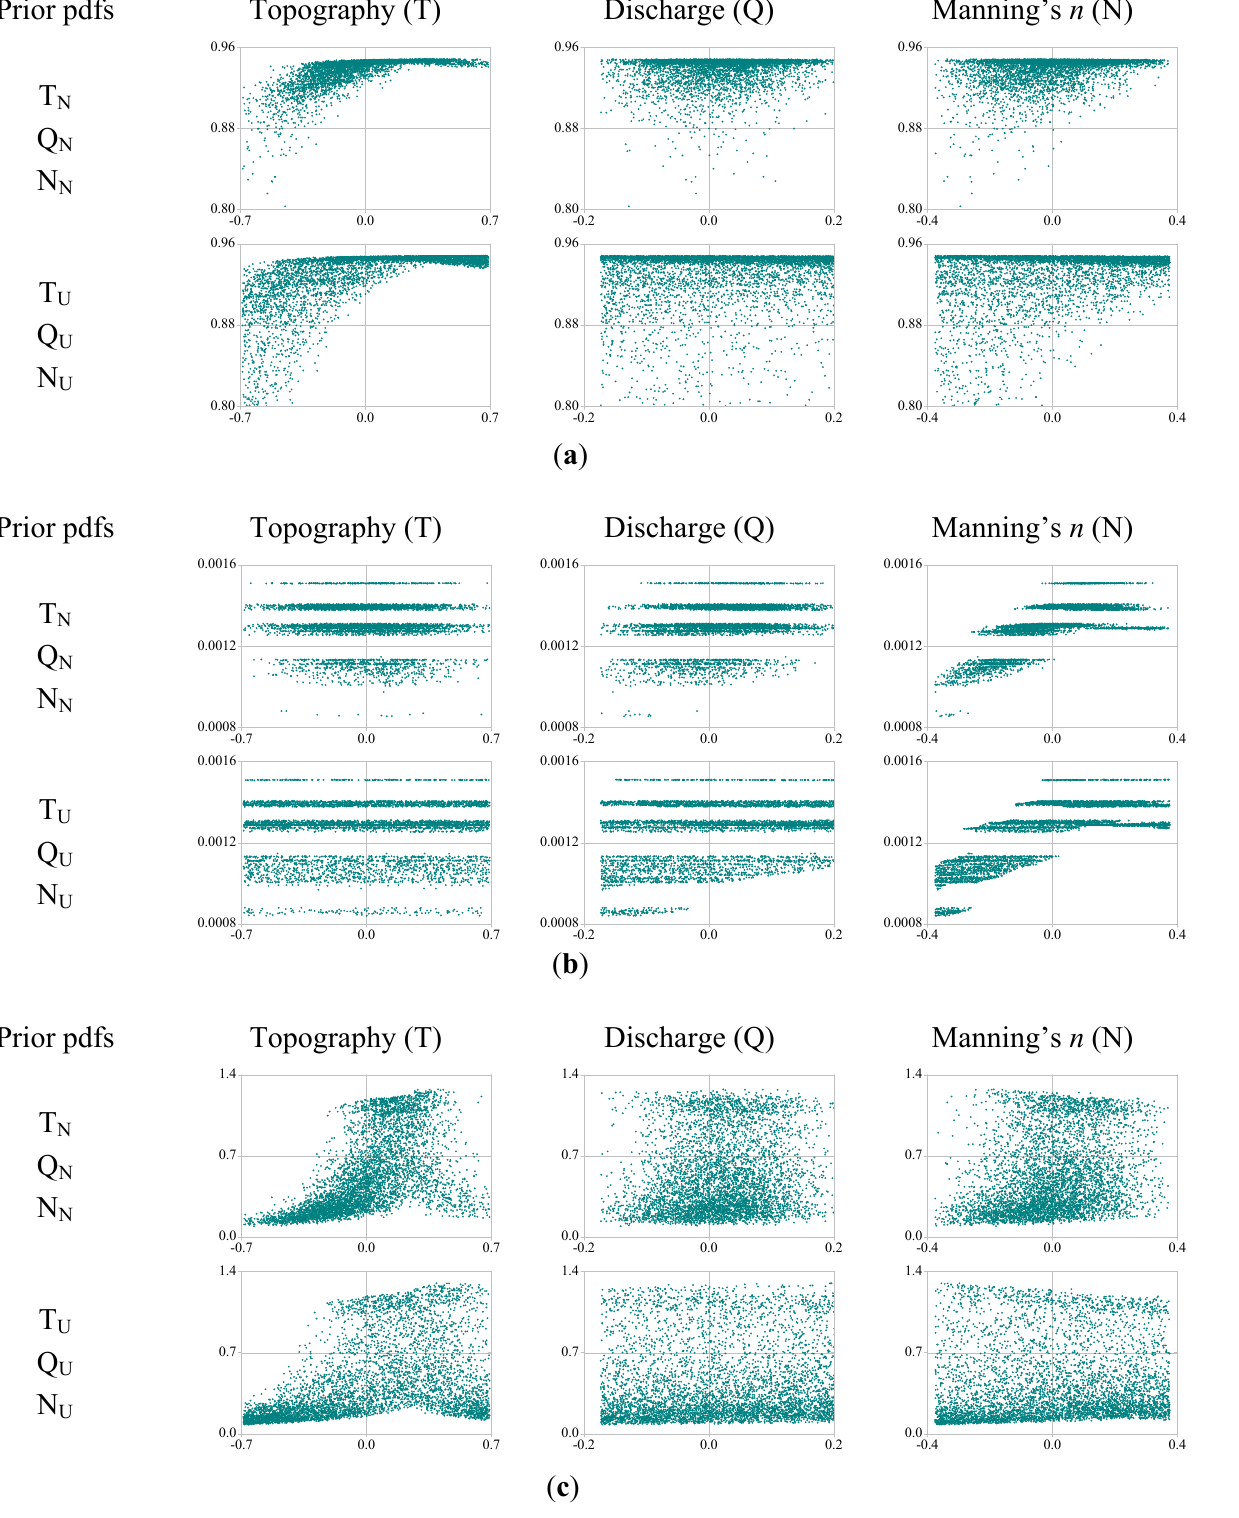
Figure 3. Dot plots of model variables (T, Q and N) based on likelihood measures and the combination of the prior pdfs (Cases 1 and 8), where the x-axis indicates the error ranges of variables and the y-axis shows the likelihood measures. ( a ) F likelihood measure; ( b ) W likelihood measures (10 3 m − 1 ); ( c) E likelihood measures (10 3 m − 1 ). Prior pdfs Topography (T) Discharge (Q) Manning’s n